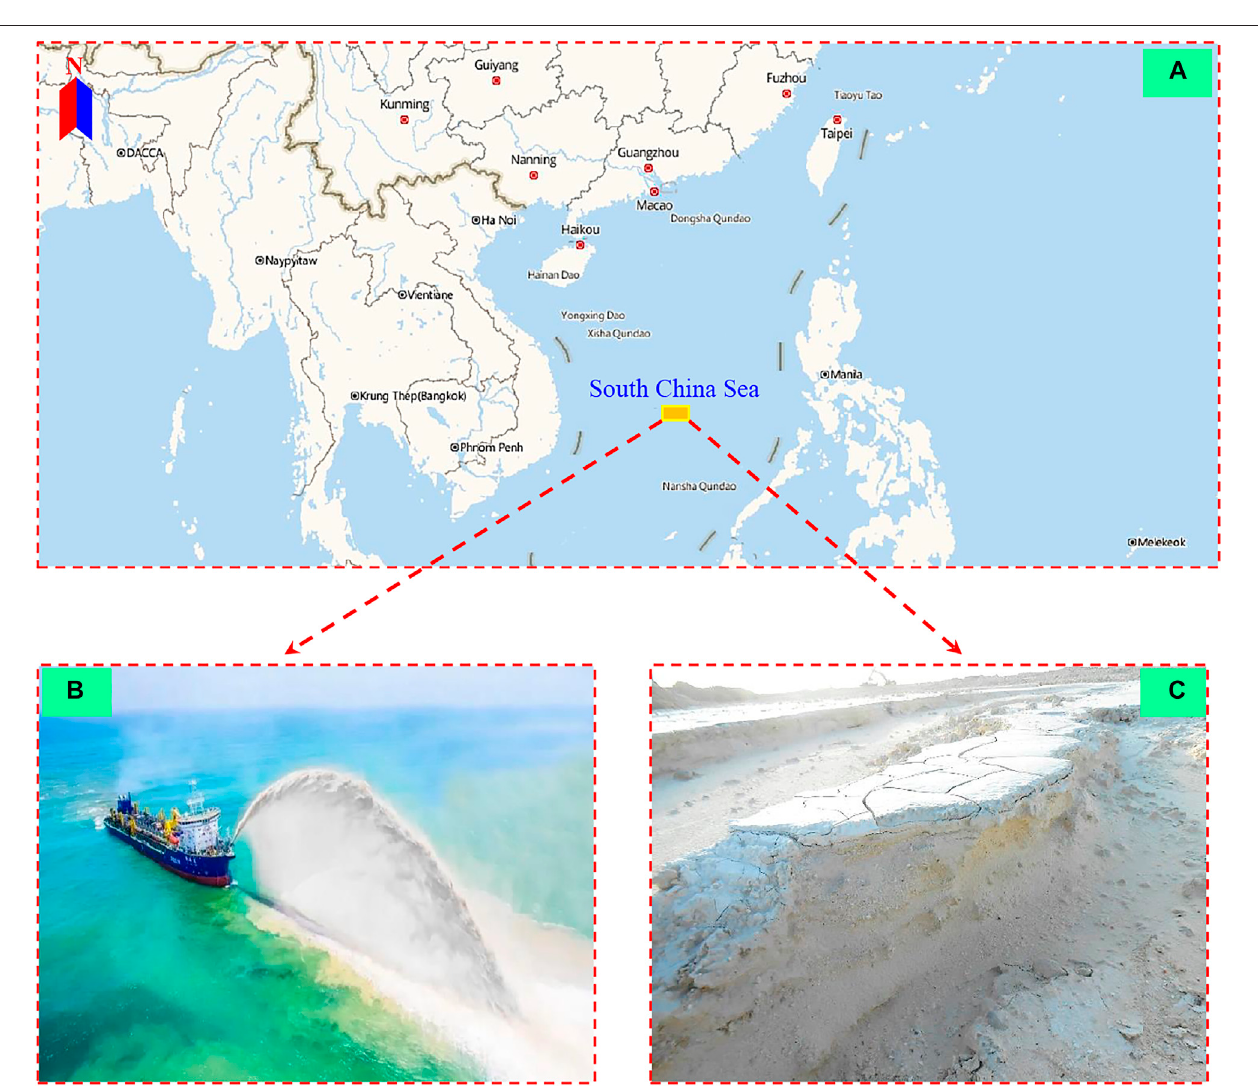
FIGURE 1 | Location of the study area (A) : location of Nansha Islands; (B) : site of hydraulic reclamation; (C) : sampling site).